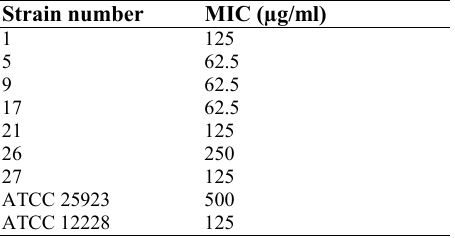
Table 3. The MIC of thyme (T. vulgaris) extract in ciprofloxacin resistant strains of S. aureus.